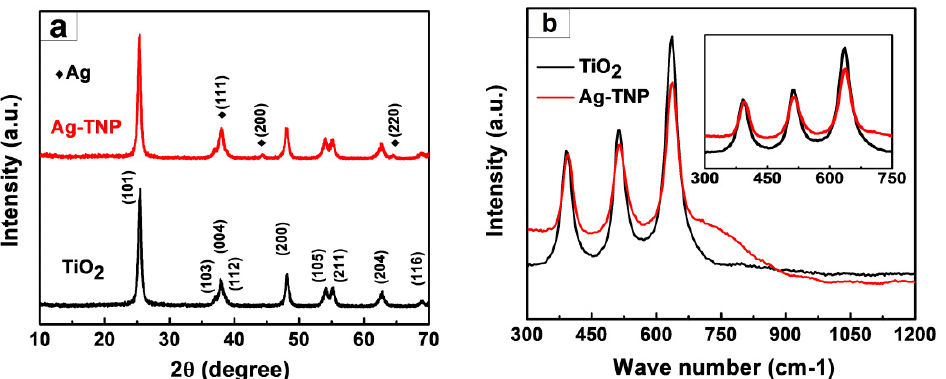
Figure 2. The crystalline structure analysis of as-prepared TiO 2 and Ag-TNP hybrids ( a ) X-ray di ff raction peaks of unmodified TiO 2 (black pattern), Ag-TNP (red pattern), and ( b ) Raman spectrum of TiO 2 (black spectrum) and Ag-TNP (red spectrum), inset in ( b ) shows the enlarged view of the Raman spectrum at the wavelength range of 300 to 750.